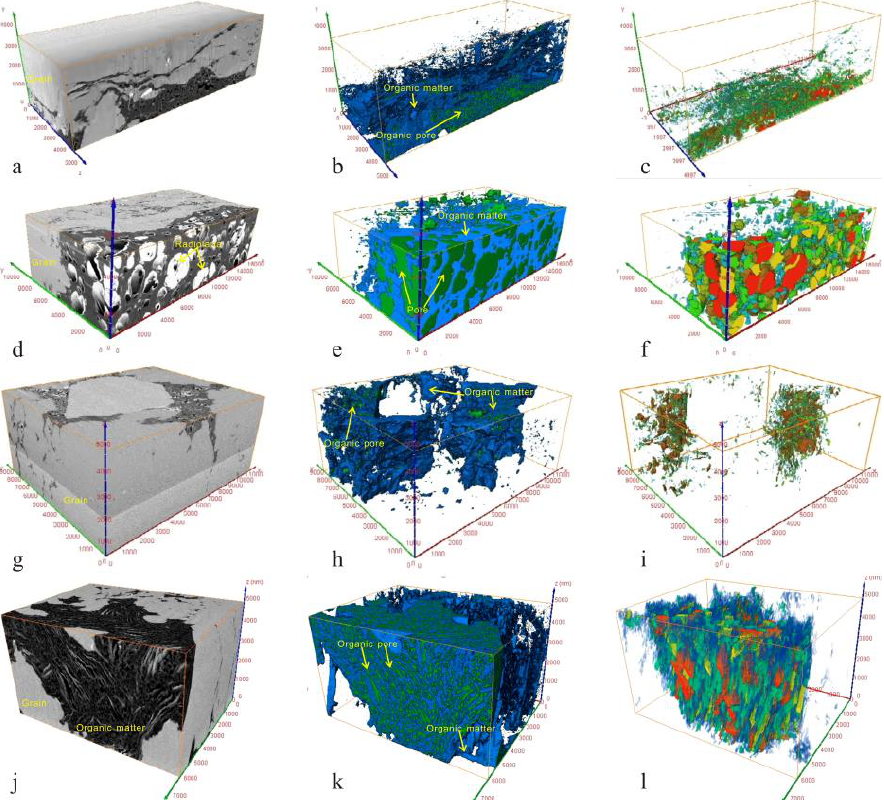
Figure 12. 3D reconstructed image of nanometric scale shale (core image, organic matter and or- ganic pores image, distribution of organic pores). ( a − c ). 2374.55 m, S 1 l 1~1d , well N3; ( d − f ). 2380.15 pores image, distribution of organic pores). ( a – c ). 2374.55 m, S 1 l 1~1d , well N3; ( d – f ). 2380.15 m, m, S 1 l 1~1c , well N3; ( g − i ). 2387.32 m, S 1 l 1~1b , well N3; ( j − l ). 2392.15 m,S 1 l 1~1a , well N3. S 1 l 1~1c , well N3; ( g – i ). 2387.32 m, S 1 l 1~1b , well N3; ( j – l ). 2392.15 m, S 1 l 1~1a , well